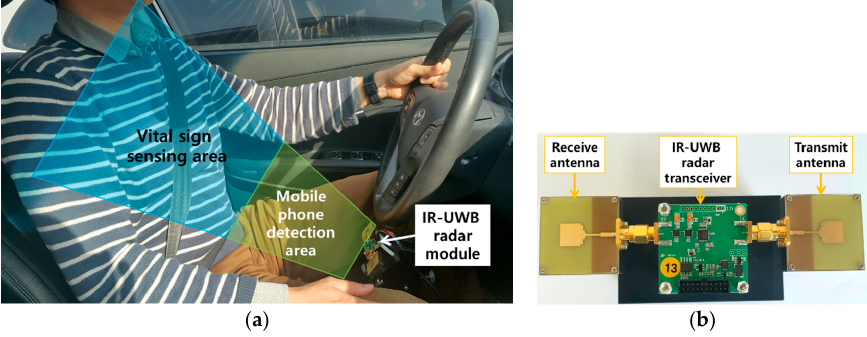
Figure 14. ( a ) Experimental setup inside the car ( b ) IR-UWB radar module.